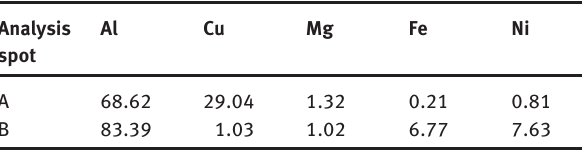
Table 2: Compositions of secondary phases at grain boundary of as-cast alloy 2618 (in at.%).